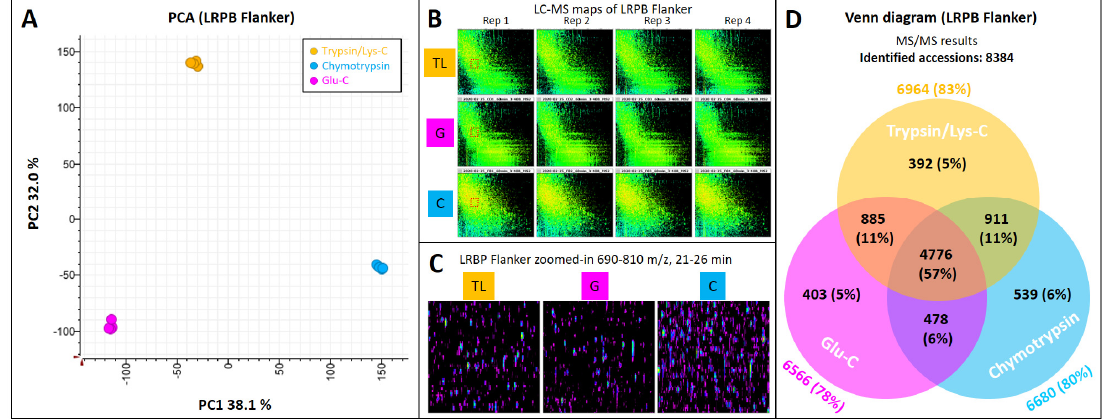
Figure 4. Testing proteases. Twenty milligrams ( ± 0.2 mg) from three wheat cultivars (LRPB Mustang, LRPB Impala, LRPB Flanker) was weighed in four replicates, extracted using 0.5 mL Gnd-HCl buffer. Protein extracts were assayed to obtain protein concentrations and 100 µ g proteins were digested using chymotrypsin, Glu-C, or trypsin/Lys-C proteases. LC–MS/MS data were acquired using LC method 1. ( A ) PC1 vs. PC2 plot based on LC–MS quantitative data; ( B ) LC–MS maps of LRPB Flanker cultivar for each of the proteases tested across four technical replicates, boxed sections are zoomed-in in panel C; ( C ) zoomed-in section of LC–MS maps at 21–26 min and 690–810 m / z to highlight cluster qualitative and quantitative differences; ( D ) Venn diagram of the identified accessions for each protease. TL, trypsin/Lys-C; G, Glu-C; C,